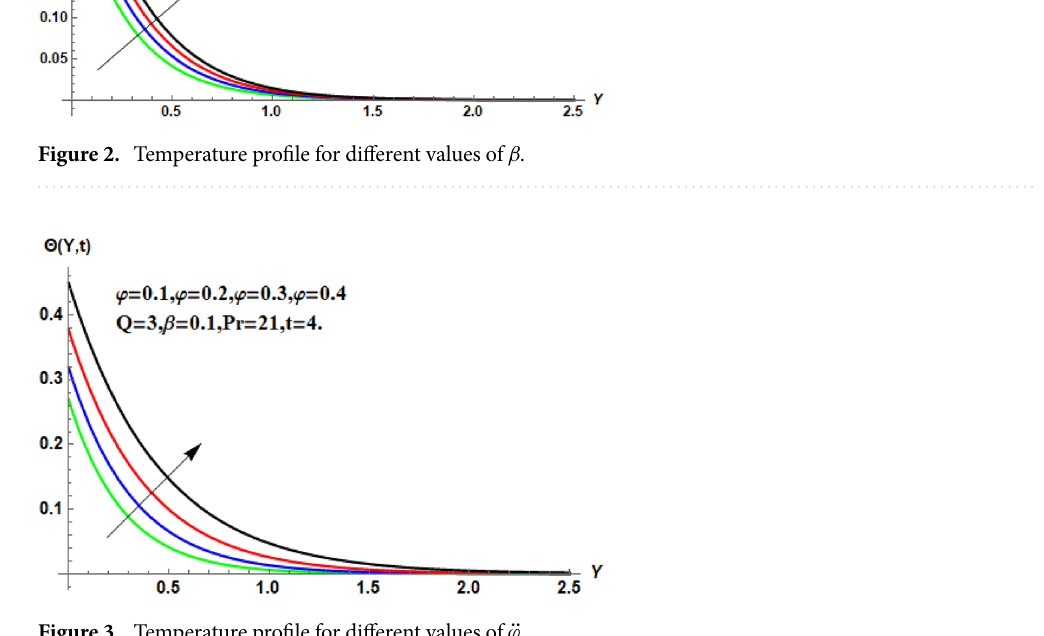
Figure 3. Temperature profile for different values of ¨ ϕ .